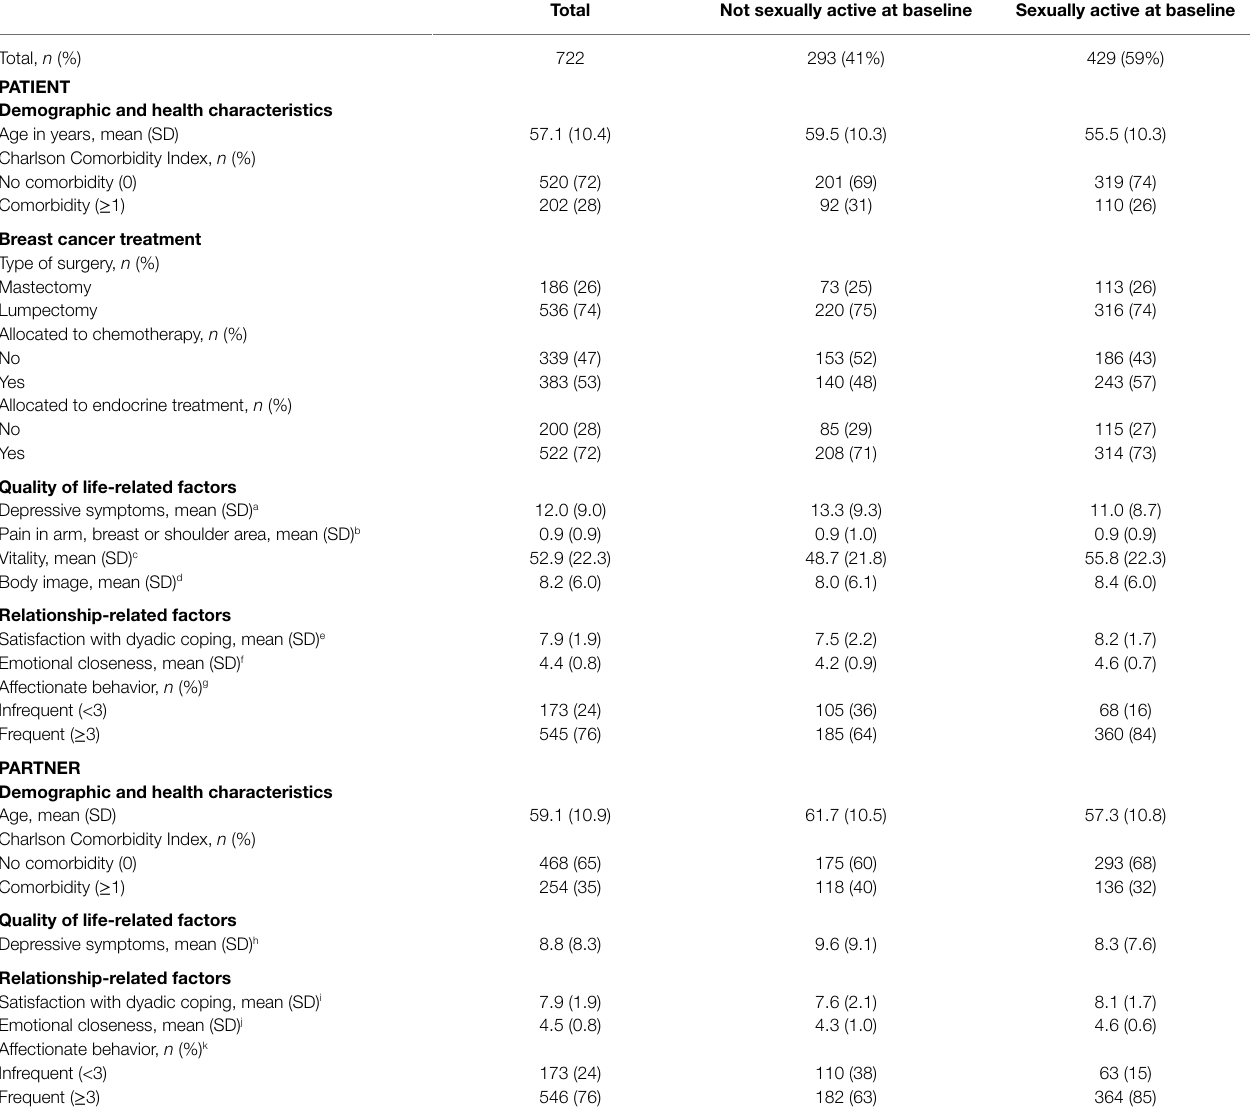
TABLE 1 | Baseline patient and partner characteristics of 722 couples, stratified on couple sexual activity. Total Not sexually active at baseline Sexually active at